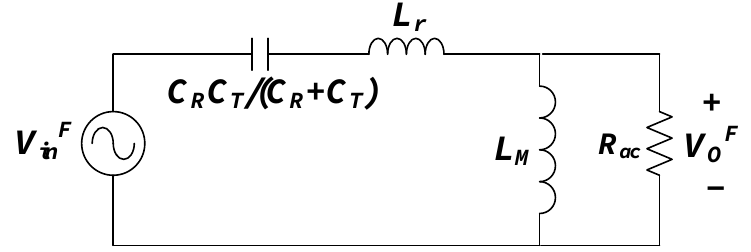
Figure 9. Equivalent circuit model in LLC resonance operation.